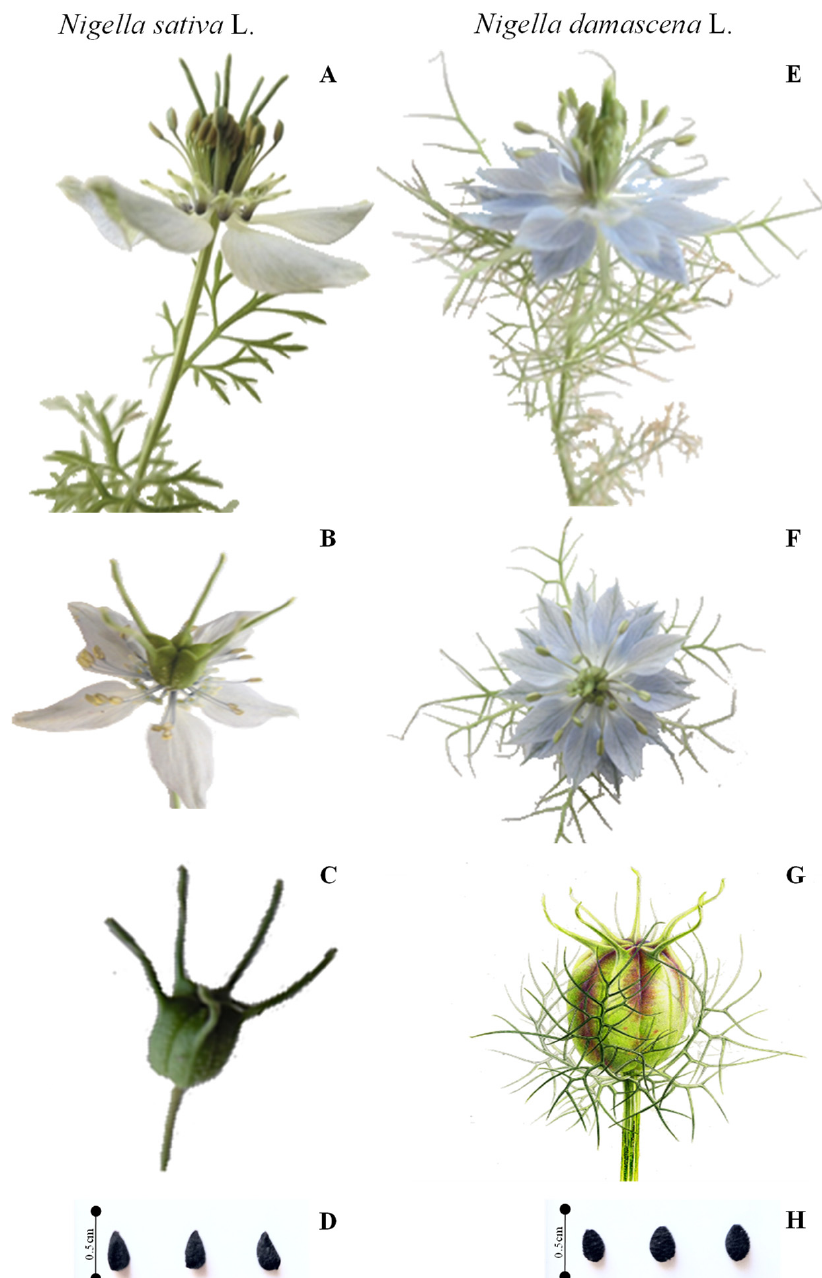
Figure 1. Photographs of aerial parts, flowers, fruits, and seeds of Nigella sativa L. ( A – D ) and Nigella damascena L. ( E – H ).